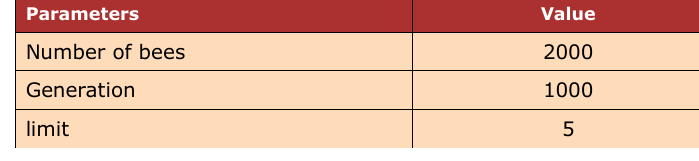
Table 4. Parameter of ABC